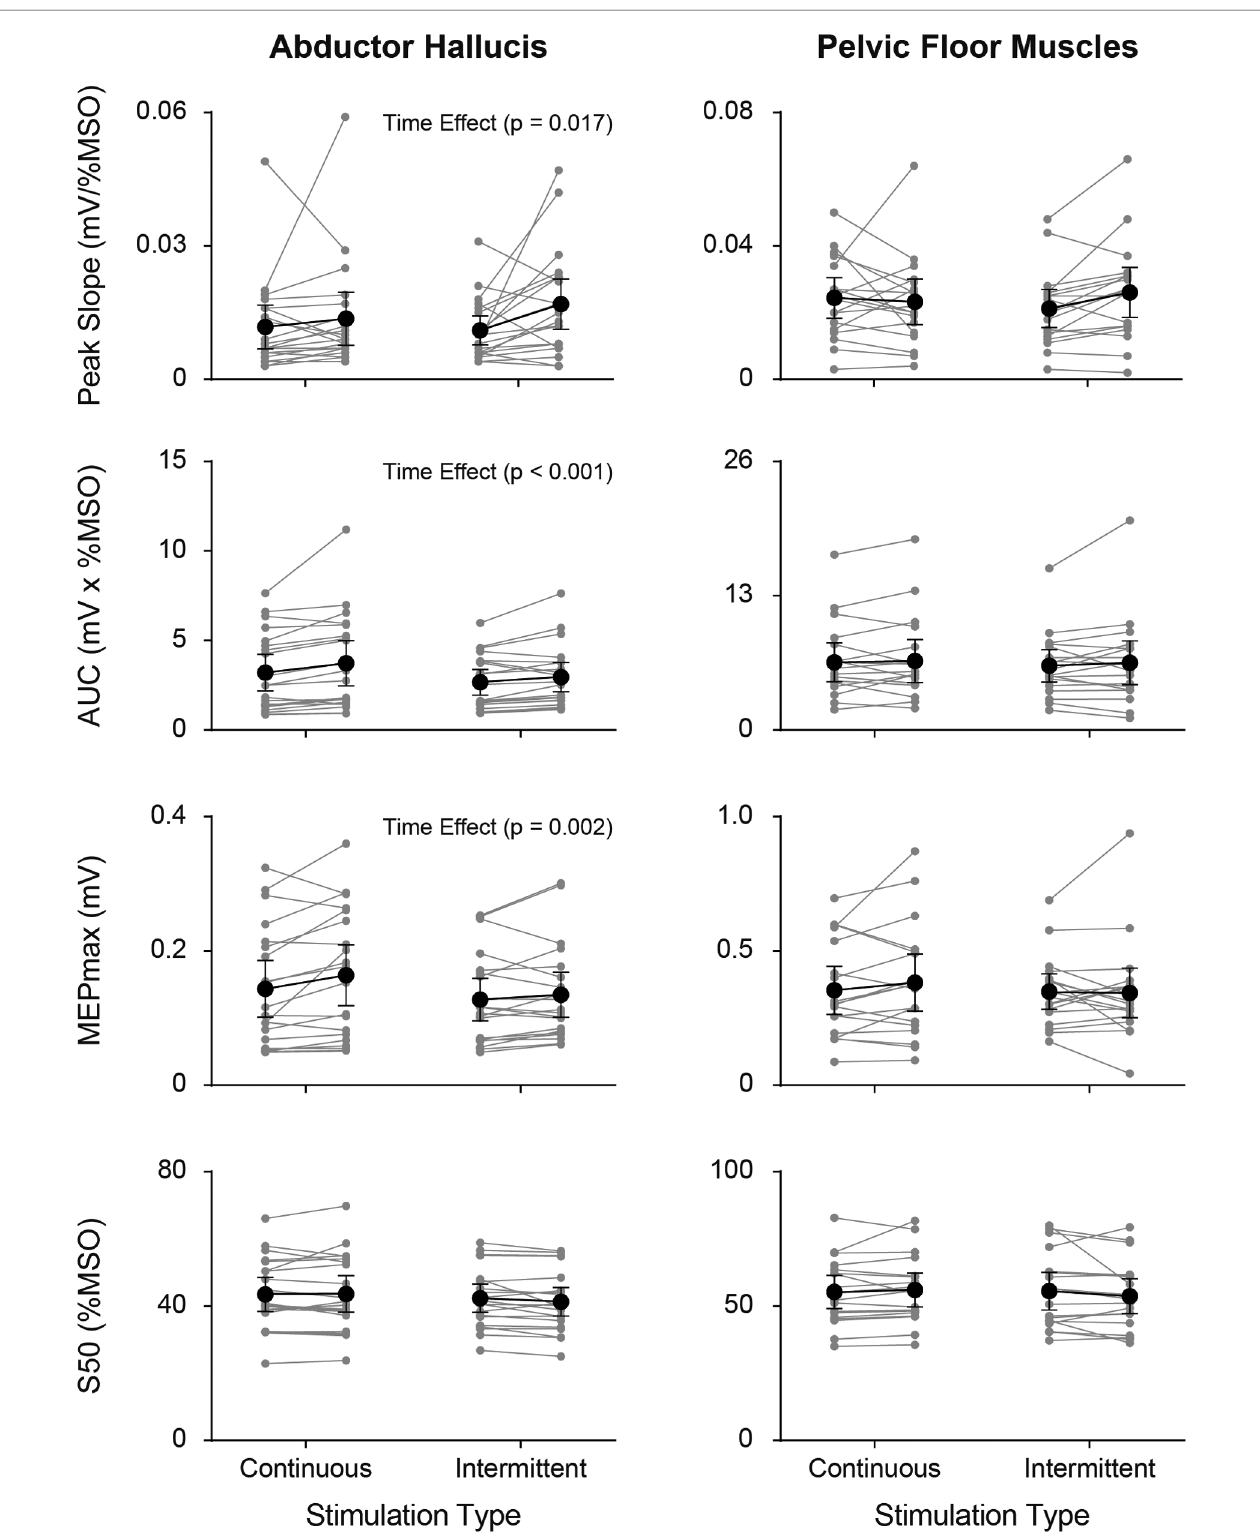
FIGURE 5 Individual (grey symbols) and mean group (black symbols) values of each SR curve parameter (peak slope, AUC, MEPmax, and S50) from the AH (left panel) and PFM (right panel) pre- vs. post-TibNS. Data from continuous TibNS are plotted on the left side of the graphs and data from intermittent TibNS are plotted on the right. Error bars represent 95% con fi dence